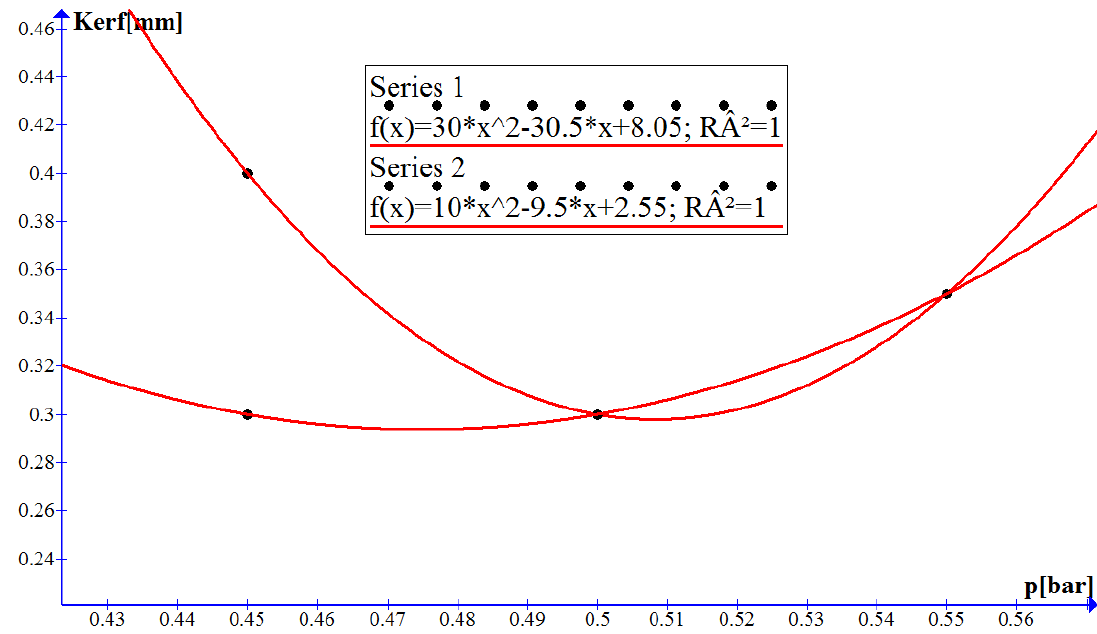
Figure 5. Influence of auxiliary gas pressure on cutting width.